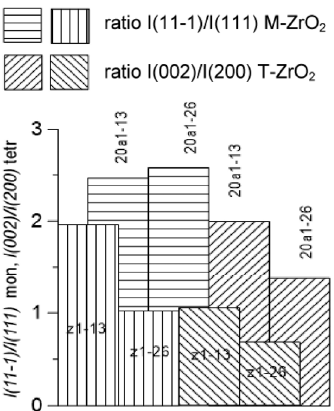
Fig. 9 Monoclinic and tetragonal-phase peak intensity ratios I 11-1 /I 111 and I 002 /I 200 , respectively, for Y-TZP (z) and Y-TZP-Al 2 O 3 (20a) after sliding at 1 m/s 13 N (1 − 13) and 1m/s 26 N (1 − 26).